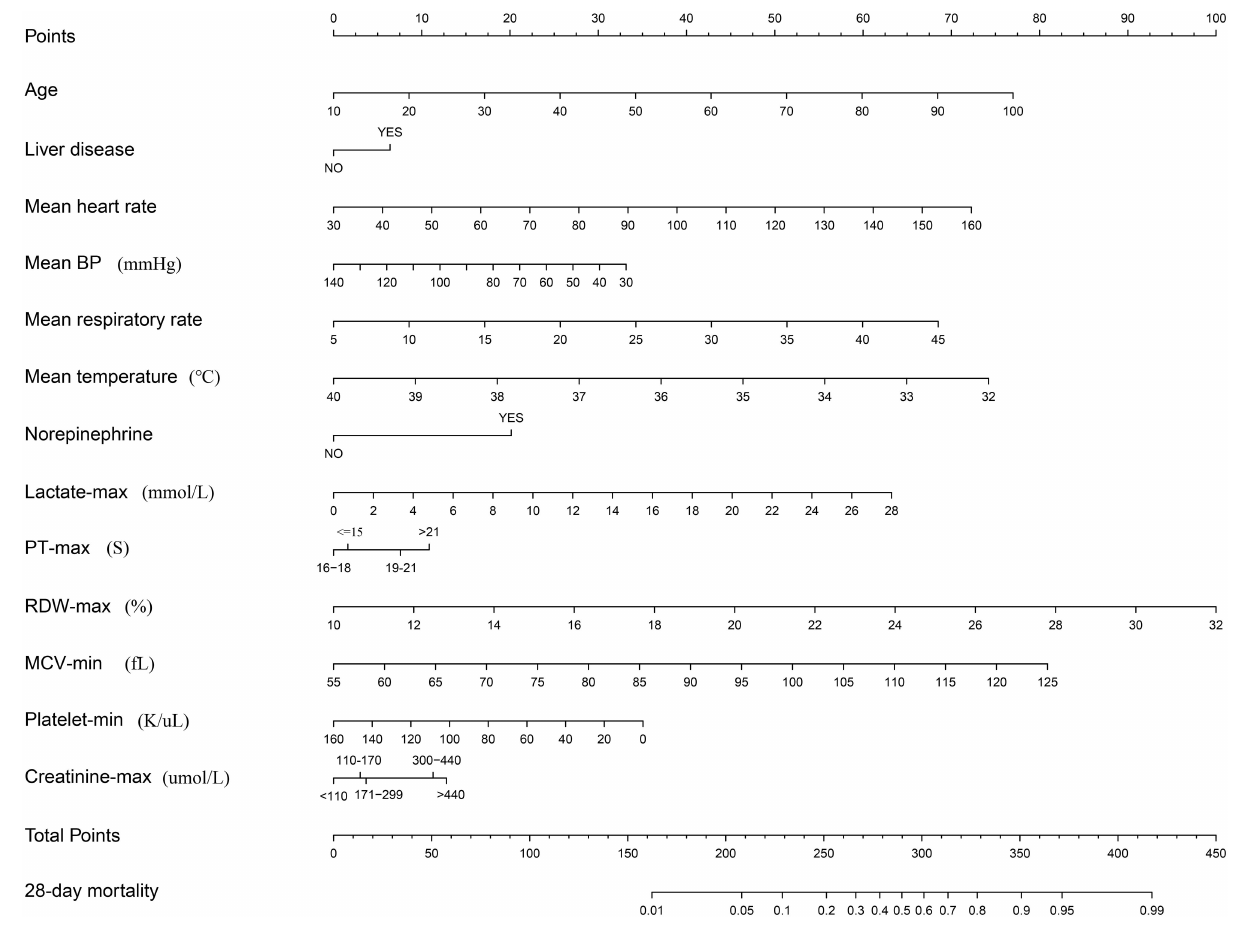
FIGURE 1 | Nomogram to predict the risk of 28-day mortality of patients with SIC. When using it, drawing a vertical line from each variable to the points axis for the score, then the points for all the parameters were added, finally, a line from the total points axis was drawn to correspond the risk of 28-day mortality at the